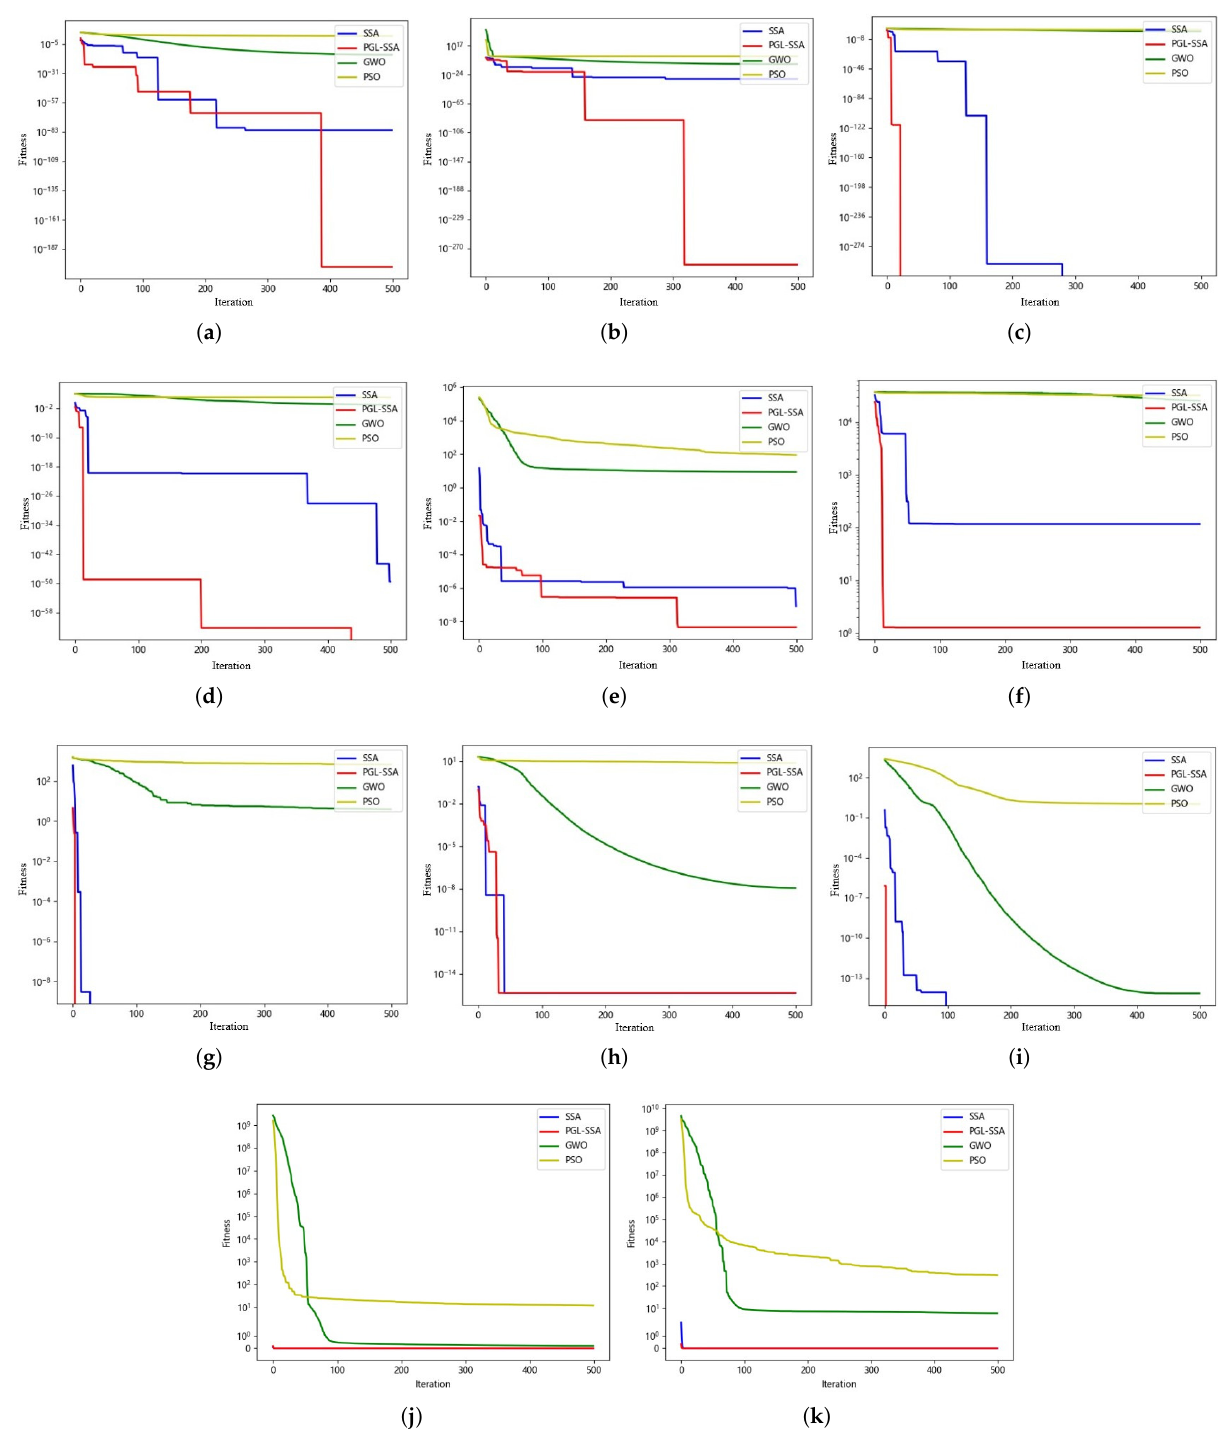
Figure 5. Different algorithms convergence curves of F1–F11 with 100 dimensions. ( a ) F1 Convergence curve. ( b ) F2 Convergence curve. ( c ) F3 Convergence curve. ( d ) F4 Convergence curve. ( e ) F5 Convergence curve. ( f ) F6 Convergence curve. ( g ) F7 Convergence curve. ( h ) F8 Convergence curve. ( i ) F9 Convergence curve. ( j ) F10 Convergence curve. ( k ) F11 Convergence